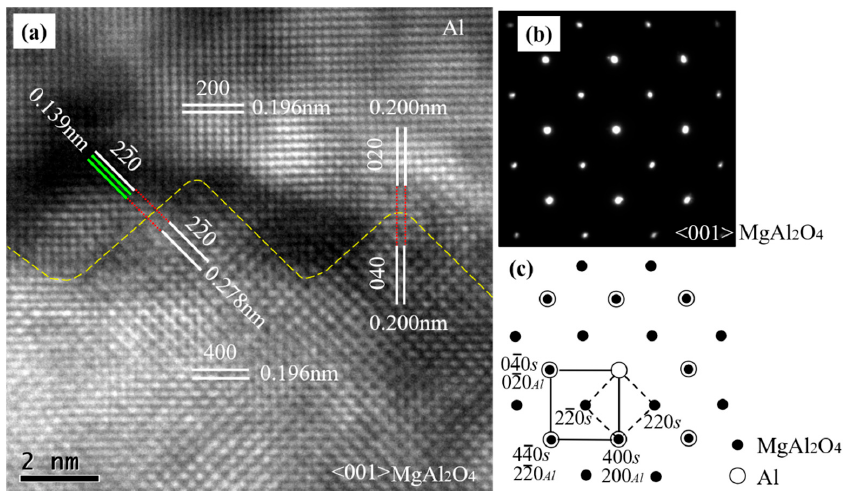
Figure 3. ( a ) High-resolution TEM image of Al/MgAl 2 O 4 taken in the <001> MgAl 2 O 4 -zone direction; ( b ) selected area electron diffraction (SAED) pattern taken from both the MgAl 2 O 4 (spinel, S) particle and the adjacent Al; and ( c ) the schematic of the pattern indexed along the <001> axis for both the MgAl 2 O 4 and Al crystals, showing the cube-on-cube crystallographic orientation relationship (OR) between the two phases.